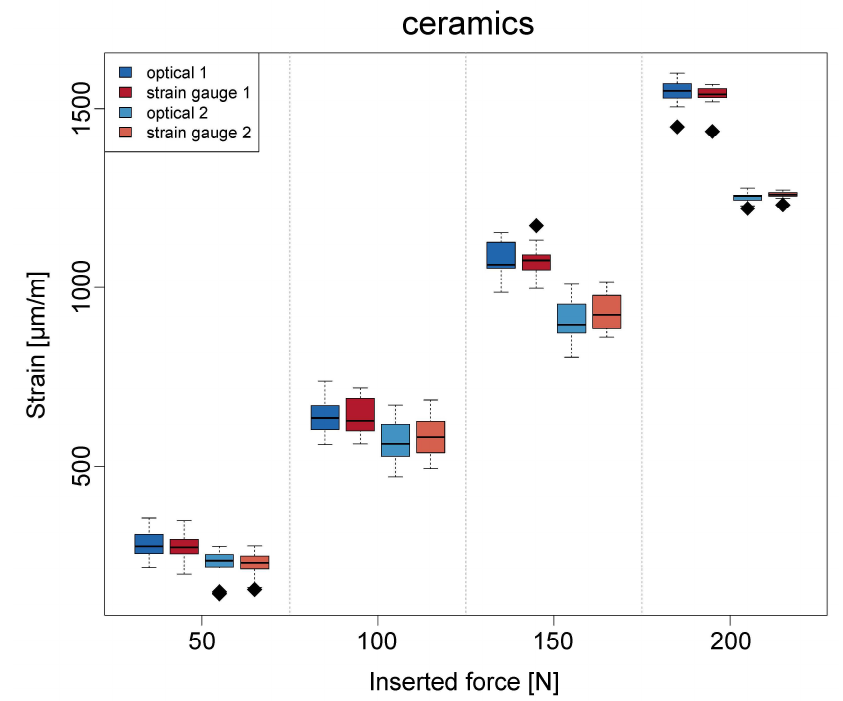
Figure 4. Boxplots regarding the strain at different inserted forces and in the case of the ceramic (zirconia) superstructure.